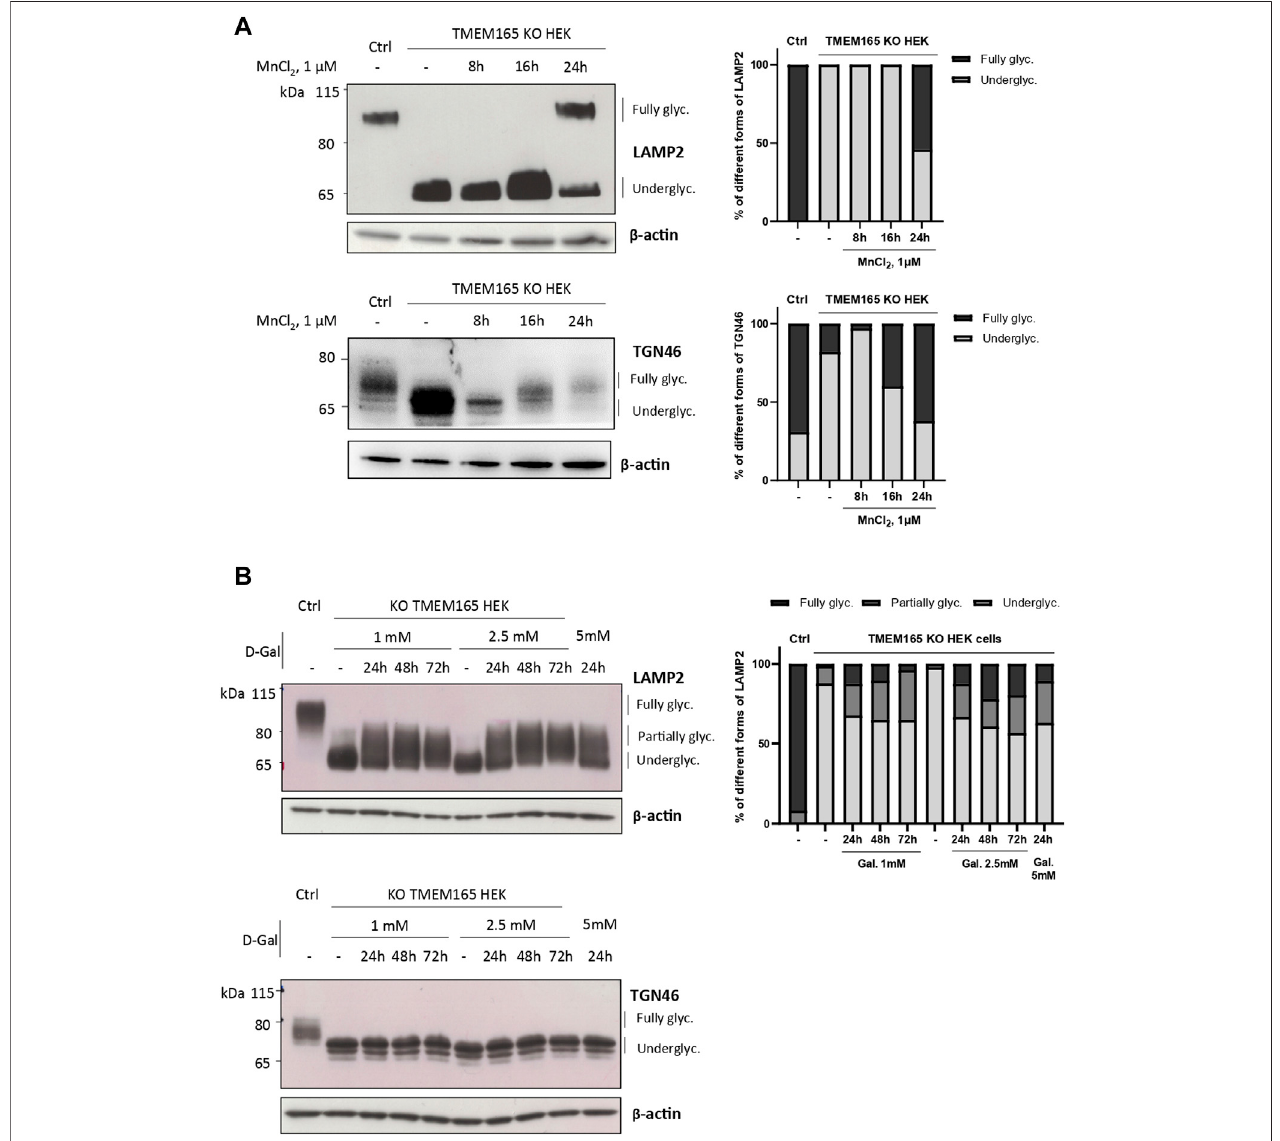
FIGURE1| Differentialimpact ofMn 2+ and D-GalactosetreatmentsonLAMP2 and TGN46 glycosylation pro fi lesin TMEM165KOHEK cells. (A) .Western-blotsof LAMP2 and TGN46 in control (Ctrl) and TMEM165 KO HEK cells, treated with 1 µM MnCl 2 for 8, 16 and 24 h. Graphs show the relative quanti fi cation of fully and underglycosylated forms of LAMP2 and TGN46. (B) . Western-blots of LAMP2 and TGN46 in control (Ctrl) and TMEM165 KO HEK cells, treated with 1 or 2.5 mM D -galactose (D-Gal) for the indicated times. In both panels, the electrophoretic migration positions of the fully- and under-glycosylated forms of proteins are indicated on the right side. The graph shows the relative quanti fi cation of fully, partially and underglycosylated forms of LAMP2 ( n = 3).